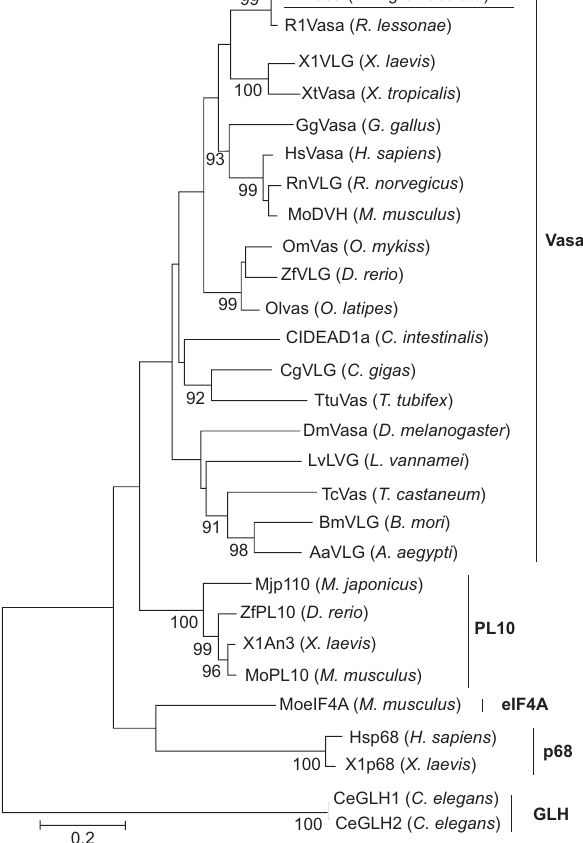
Figure 2. Phylogenetic trees of the deduced amino acid sequence of RnVasa and the complete amino acid sequences of 27 other DEAD-box proteins from different species. Numbers next to nodes are bootstrap values based on 1000 replicates, which indicate the reliability of branches in each tree. Branches with less than 90% support have been collapsed. Scale bars indicate number of sub- stitutions per 100 amino